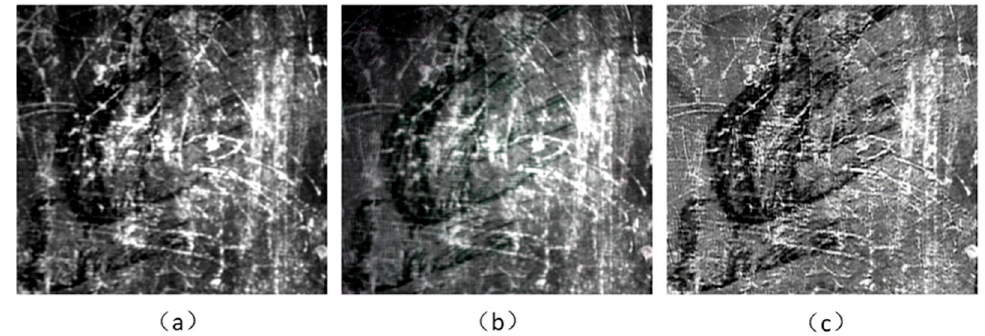
Figure 4. ( a ) Extracting the region of interest (ROI) from area 1; ( b ) average spectral curves of the mural pattern (purple) and sootiness (green).